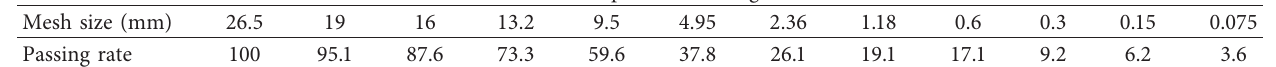
Table 5: AC-20 asphalt concrete gradation.